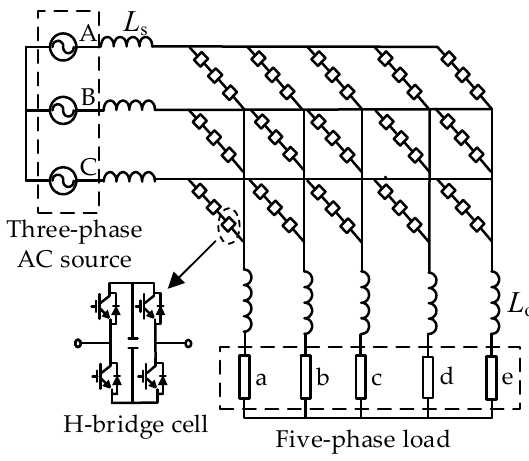
Figure 1. Main circuit topology of 3 × 5 M3C.